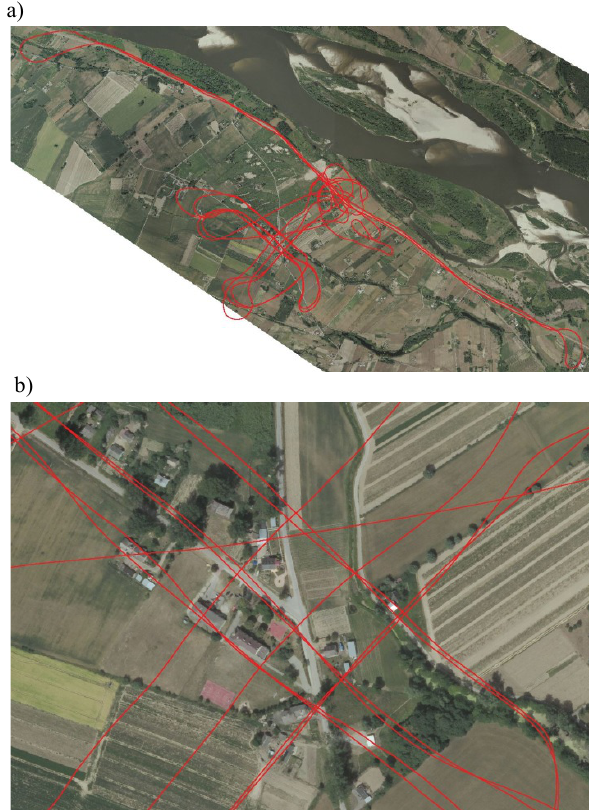
Figure 2. Trajectory of the entire flight over the levees (a) and above Świniary village (b)